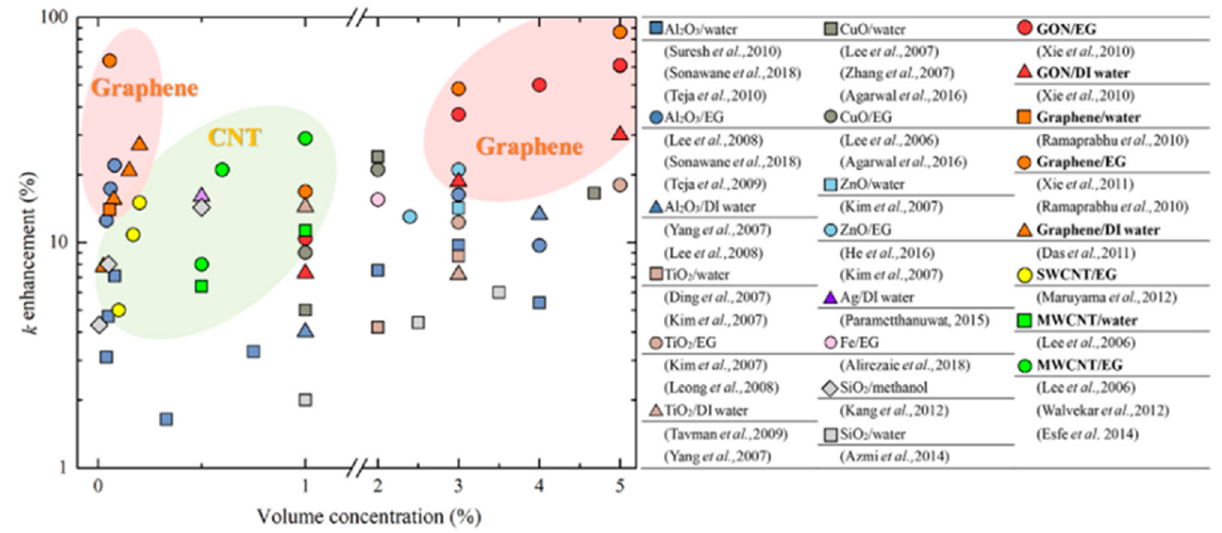
Figure 12. Schematic diagram for the dependence of the thermal conductivity of nanofluids on volume concentration in various studies [173].